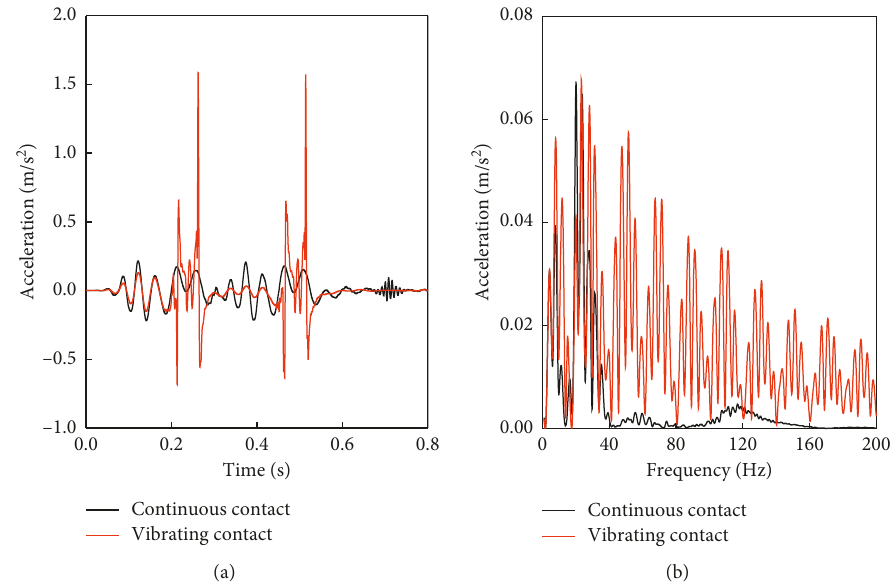
Figure 9: Acceleration curves on the roadbed surface in the states of continuous contact and vibrating contact: (a) time domain and (b) frequency domain.